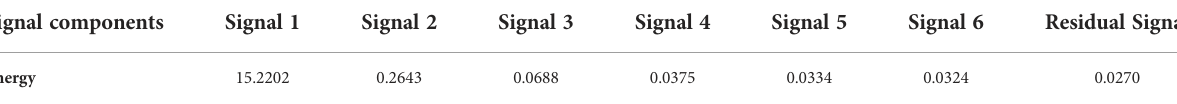
TABLE 2 The signal energy of each estimated component.